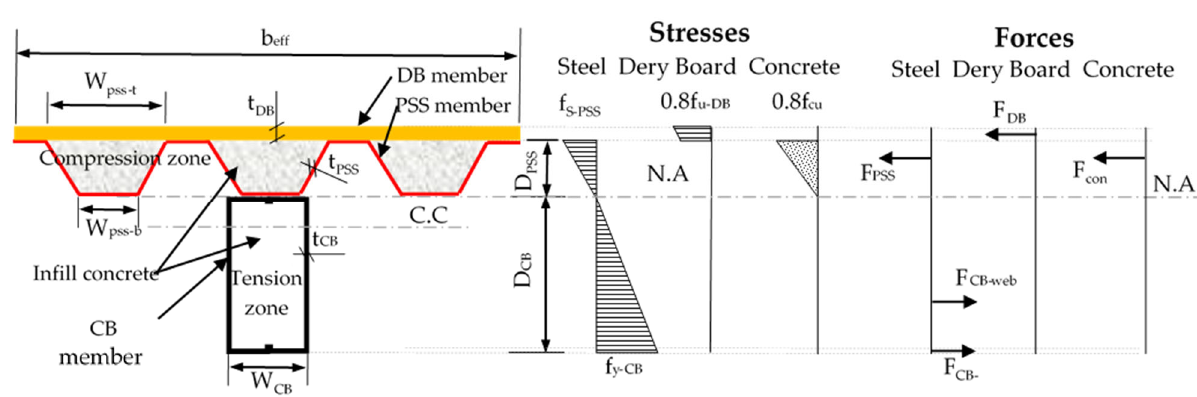
Figure 17. Stress block diagram of CBPDS system.